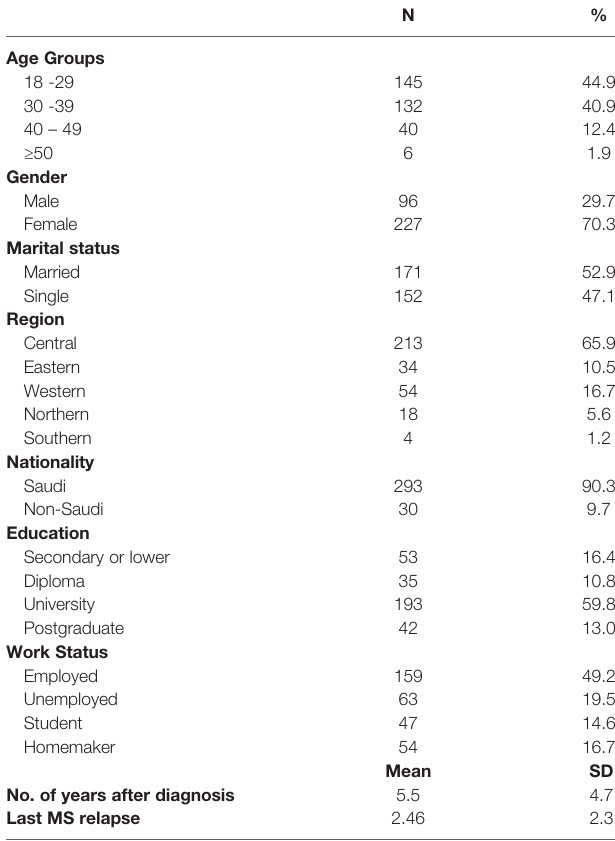
TABLE 1 | Descriptive statistics of the study